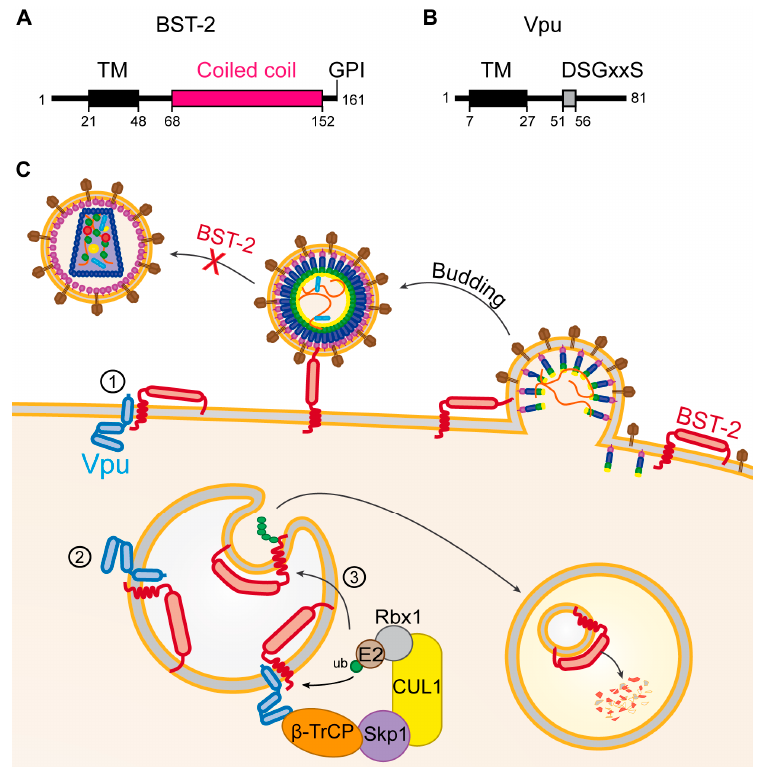
Figure 6. Restriction of HIV by BST-2 and counteraction by Vpu. ( A , B ) Schematic representation of the main domains of ( A ) the BST-2 and ( B ) Vpu proteins. Black boxes indicate transmembrane domains (TM). The glycosyl-phosphatidylinositol (GPI) modification at the C-terminal end of BST-2 is indicated. Amino acid positions of the beginning and end of the domains as well as the total length of the proteins are indicated; ( C ) mechanism of BST-2 restriction and Vpu counteraction. BST-2 tethers virions to the plasma membrane, thereby hindering their dissemination. Vpu sequesters BST-2 away from virion budding sites either at the plasma membrane ① or in intracellular compartments ② .